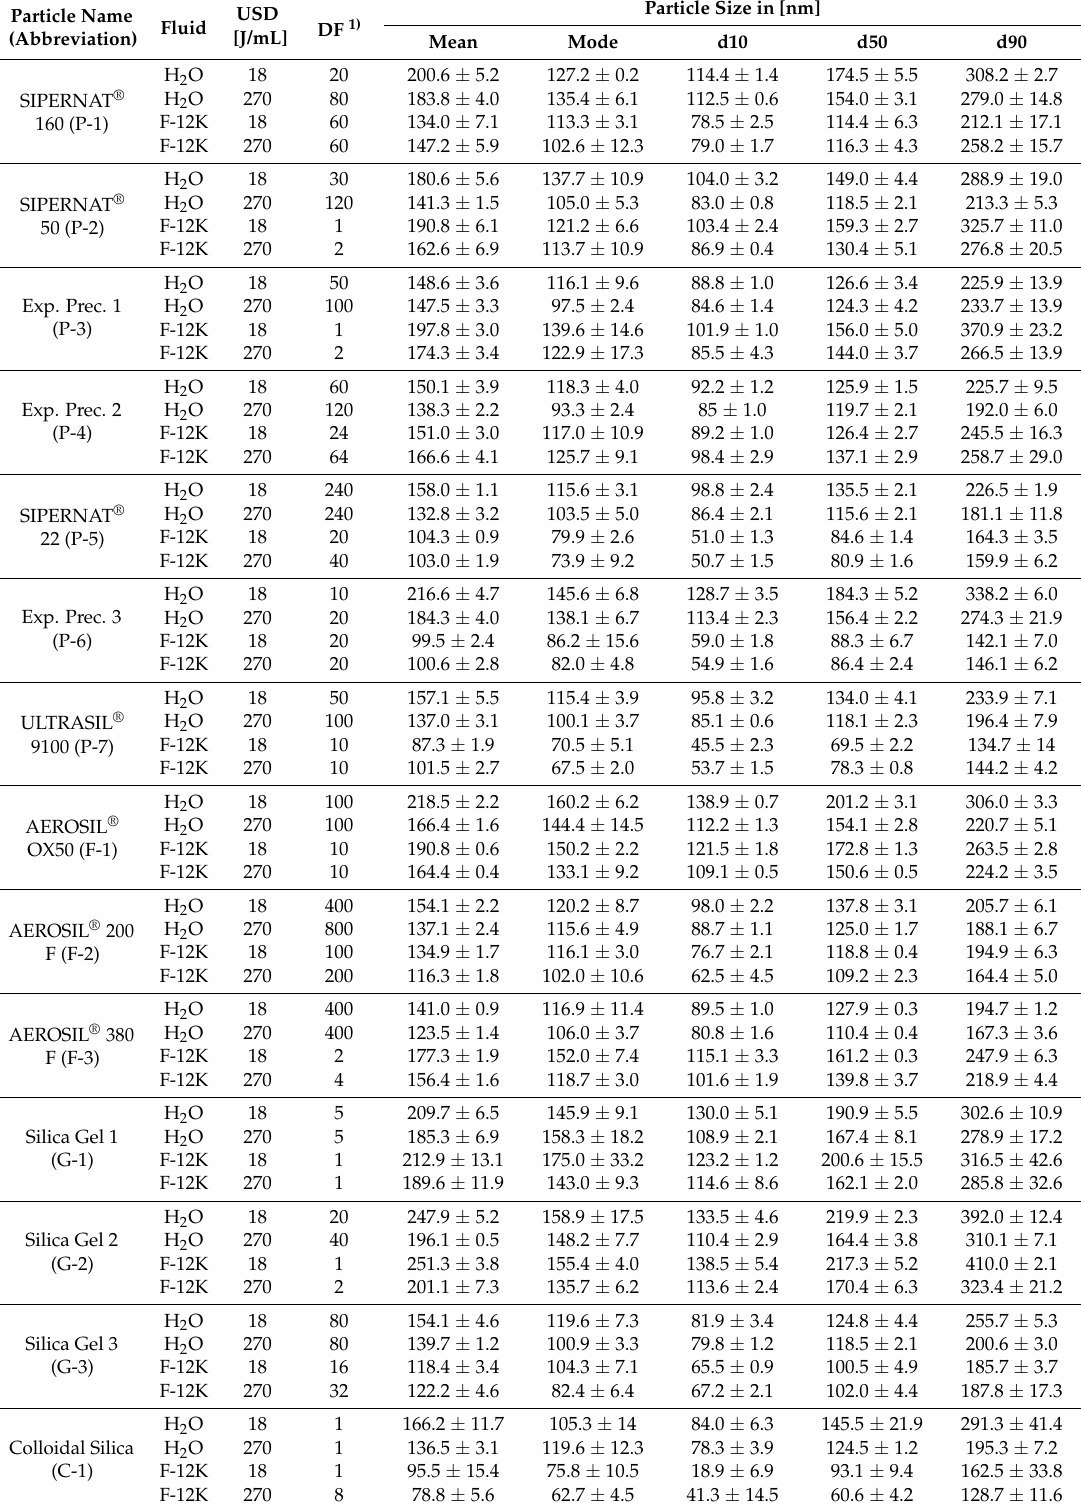
Table 5. Particle size in cell culture medium (tracking